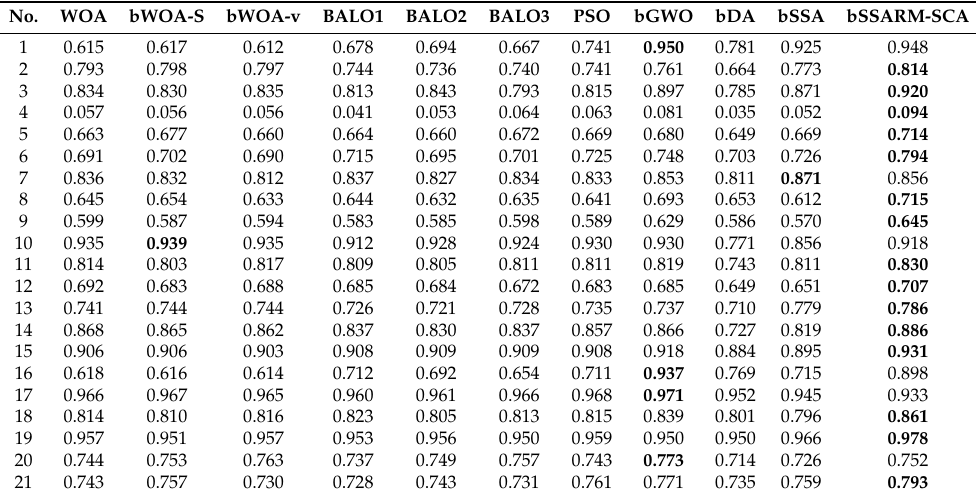
Table 13. Classification accuracy using large initialization for the 21 utilized datasets.